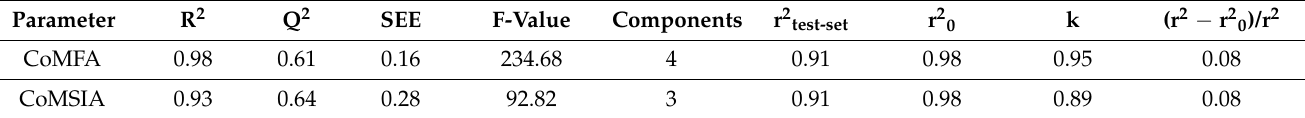
Table 2. Statistical analysis results for the best CoMFA and CoMSIA